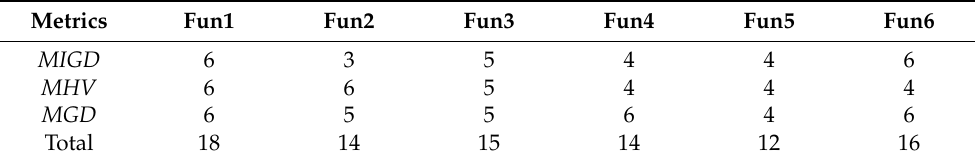
Table 4. The statistical results of six benchmarks on different metrics.